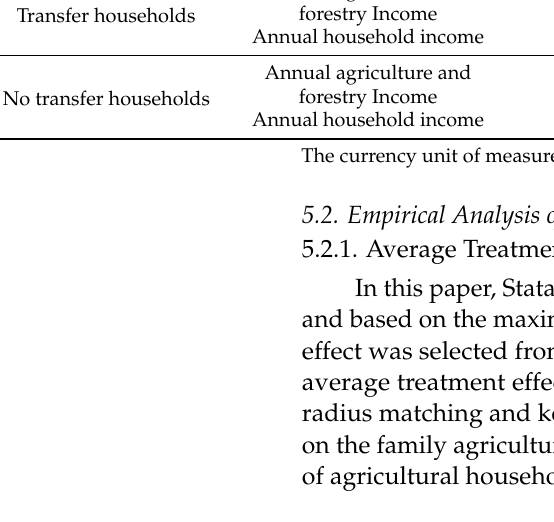
Pure Agricultural Households